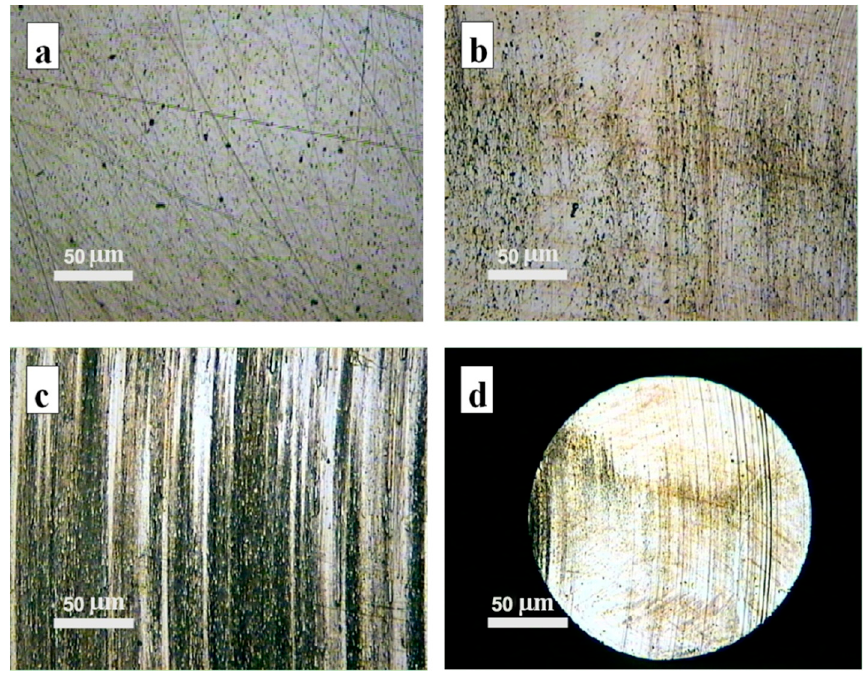
Figure 6. Optical microscope images of wear scars for Sample A2 during the reciprocating movement with durations of: ( a ) 15 min/coupon, ( b ) 30 min/coupon, ( c ) 60 min/coupon, and ( d ) 60 min/ball.